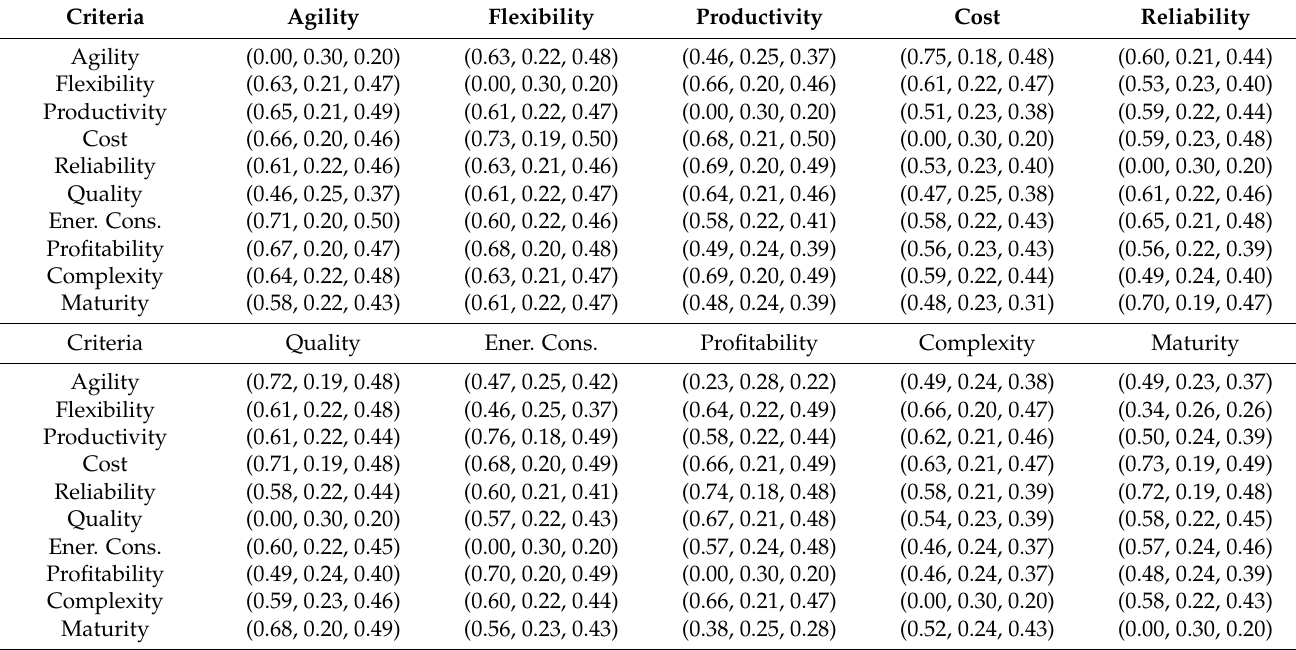
Table A2. The SF direct influence